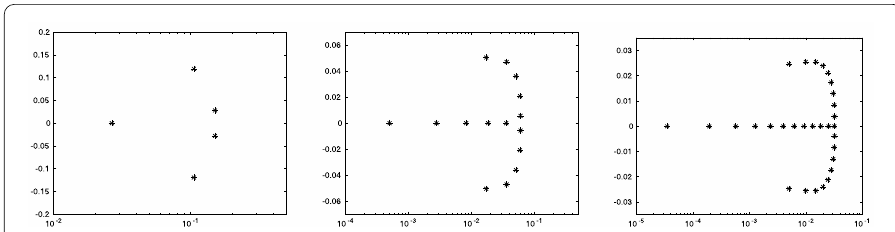
Figure 7 Eigenvalues of U n in the case of a logarithmic weight function for n = 5,15,30 (from left to right)